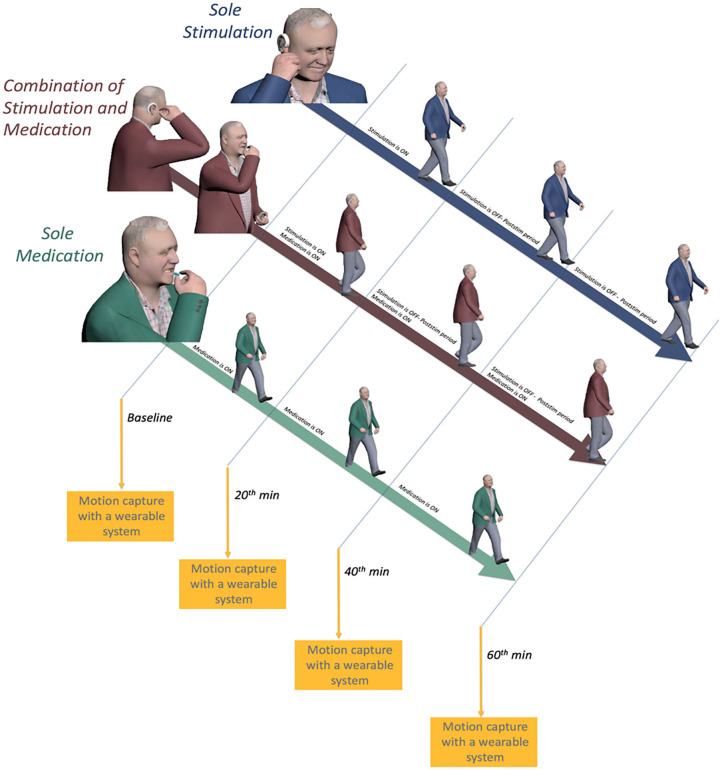
Illustration of the on and off periods of medication and auricular stimulation and motion capture sessions for all three sessions.